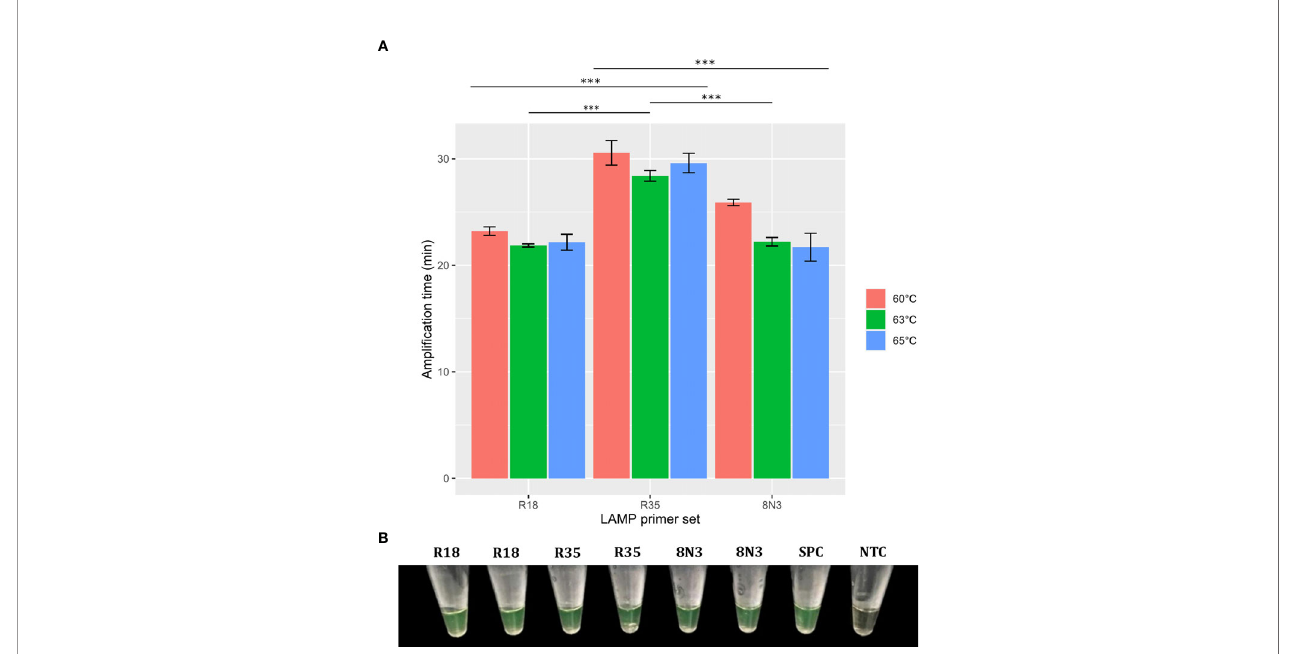
FIGURE 4 | Effect of temperature and R18, R35, and 8N3 primer sets on RT-LAMP assay performance. Error bars represent the standard deviations of the ampli fi cation time mean from independent experiments performed in duplicate. ***P < 0.001. Signi fi cance analyzed by one-way analysis of variance (ANOVA) (A) . RT- LAMP assays using the R18, R35, and 8N3 primer sets for SARS-CoV-2 detection were considered positive when the solution color changed from brown to green (B) . NTC, negative non-template control; SPC, SARS-CoV-2 positive control.